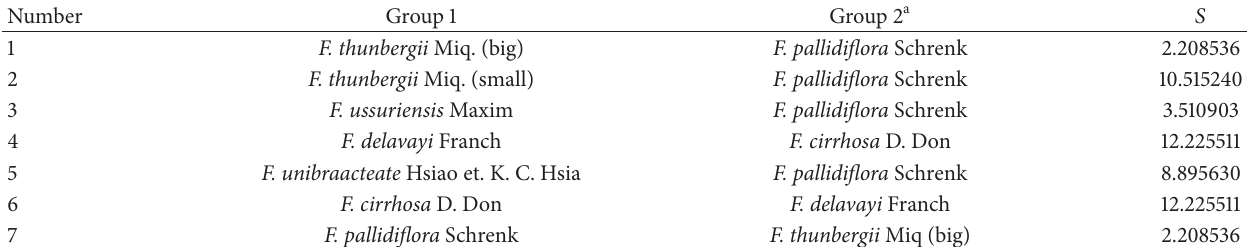
Table 1: The qualitative analysis results of the model using the first derivative method.